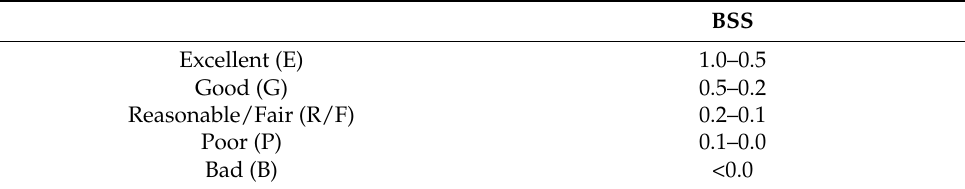
Table 3. Classification for the BSS (Adapted with permission from Ref [45], 2004, Elsevier).